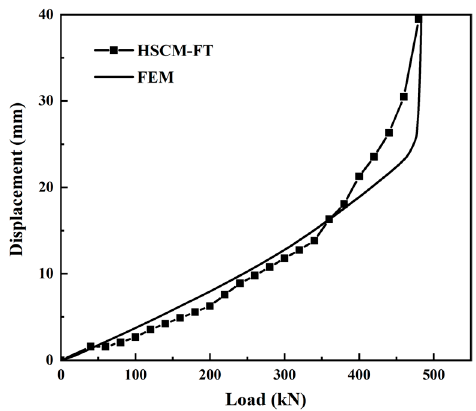
Figure 5. Comparison of field test and simulation results.